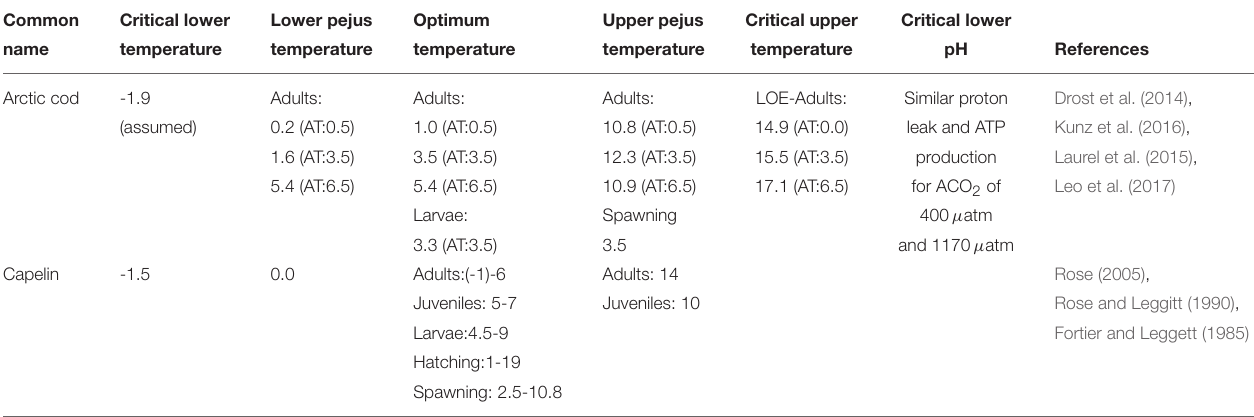
TABLE 1 | Physiological limits extract from Aquatic Species Physiological Limits database (Steiner et al., 2018). Common Critical lower Lower pejus Optimum Upper pejus Critical